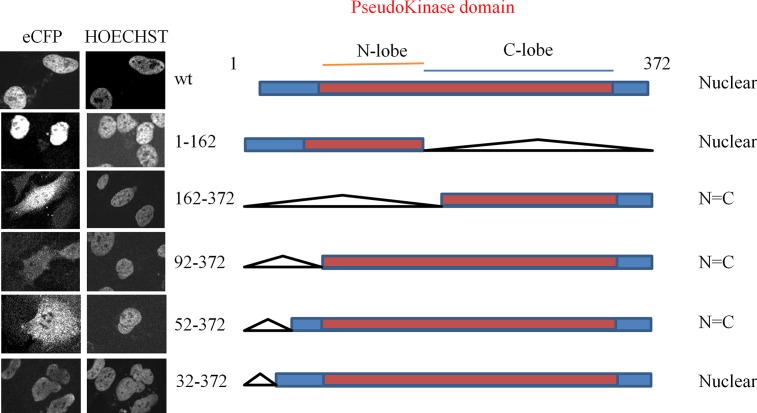
TRIB1 NLS is located near its N terminus.Variants of TRIB1 fused C-terminal to eCFP were expressed in HeLa cells for 24 h, fixed, permeabilized and subjected to fluorescence confocal microscopy using a 440 nm laser. Hoechst 33342 was included to visualize the nucleus. Data represent 2 independent experiments. Schema of the deletions is shown on the right.